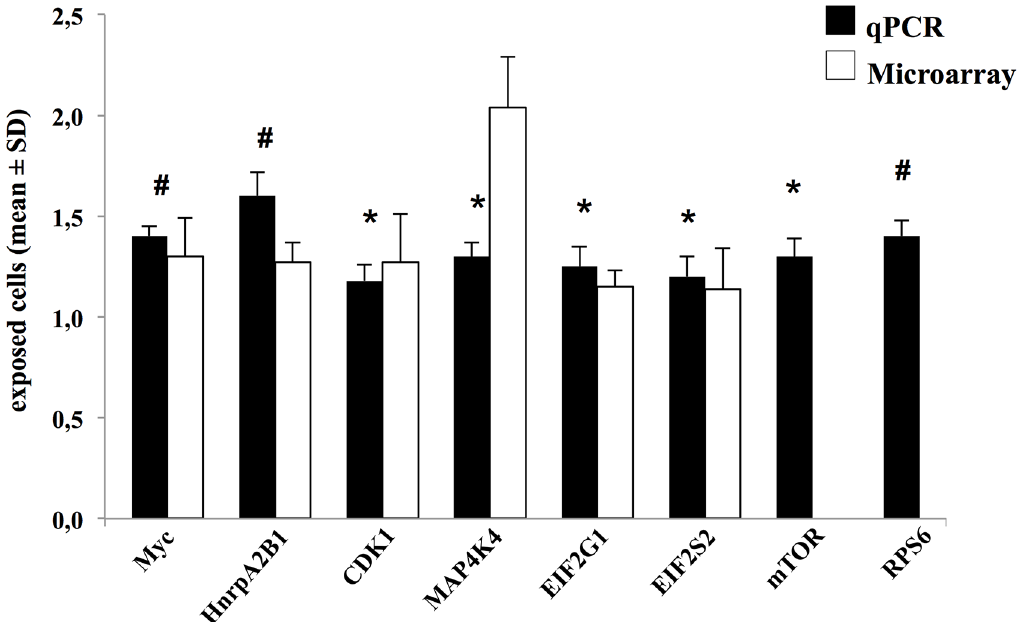
Fig 4. Validation of gene expression using SYBR Green-based qPCR. The following genes Myc, HnrpA2B1, CDK1, MAP4K4, Eif4G1, Eif2S2, mTOR and RPS6 were selected. qPCR data analysis was based on the 2 - 44 Ct method and RPS18 was used as internal control. The results are plotted as relative increase in not ELF-EMF-exposed cells ( * p < 0 . 05 , # p < 0 . 03 ). For all the cDNA templates 1ml were used in a 20 μ l qPCR amplification system of SYBR Green Real Master Mix Kit as the manufacturer directed. No qPCR products were generated from genomic versus cDNA template. No primer dimers were observed. Melting curve analysis was performed to confirm the purity of the qPCR products. For microarray, Significance Analysis of Microarrays (SAM) software was performed to determine differential mRNA expression. A false discovery rate (FDR) was set at 0% to determine significant genes. mTOR and RPS6 values did not reach the significance and were not